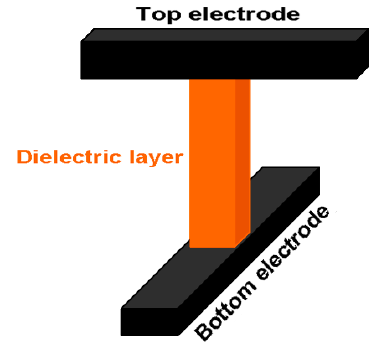
Figure 15. Typical RRAM architecture. Materials 2019 , 12 , x FOR PEER REVIEW